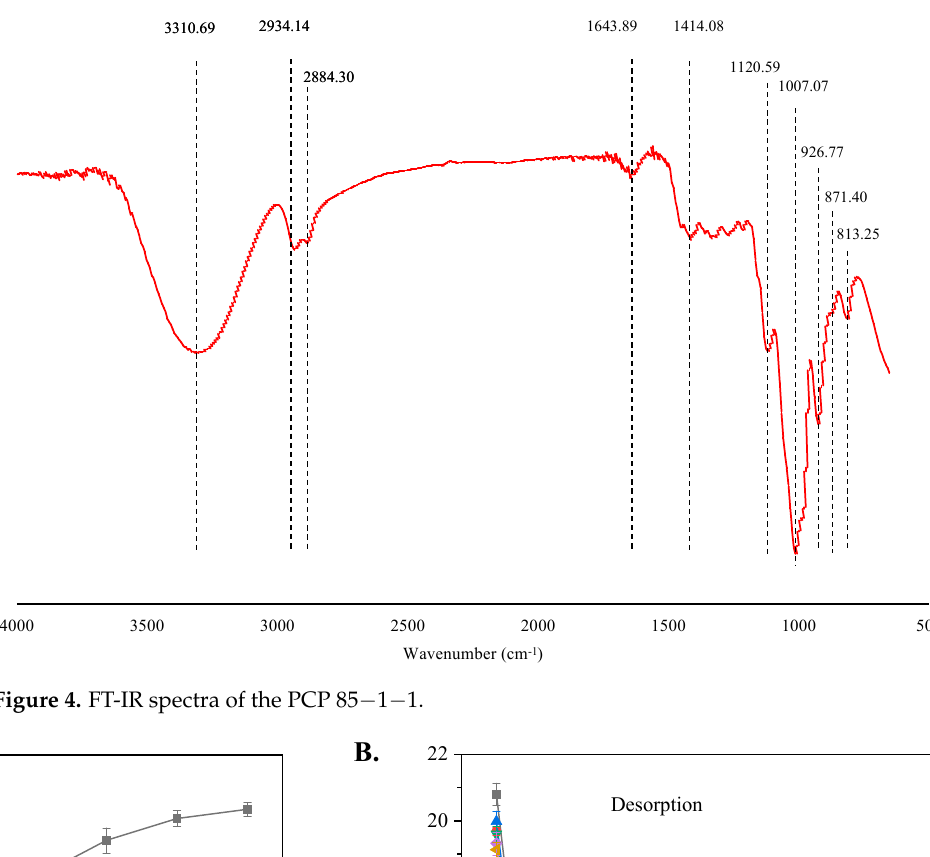
Figure 4. FT-IR spectra of the PCP 85 − 1 − 1.